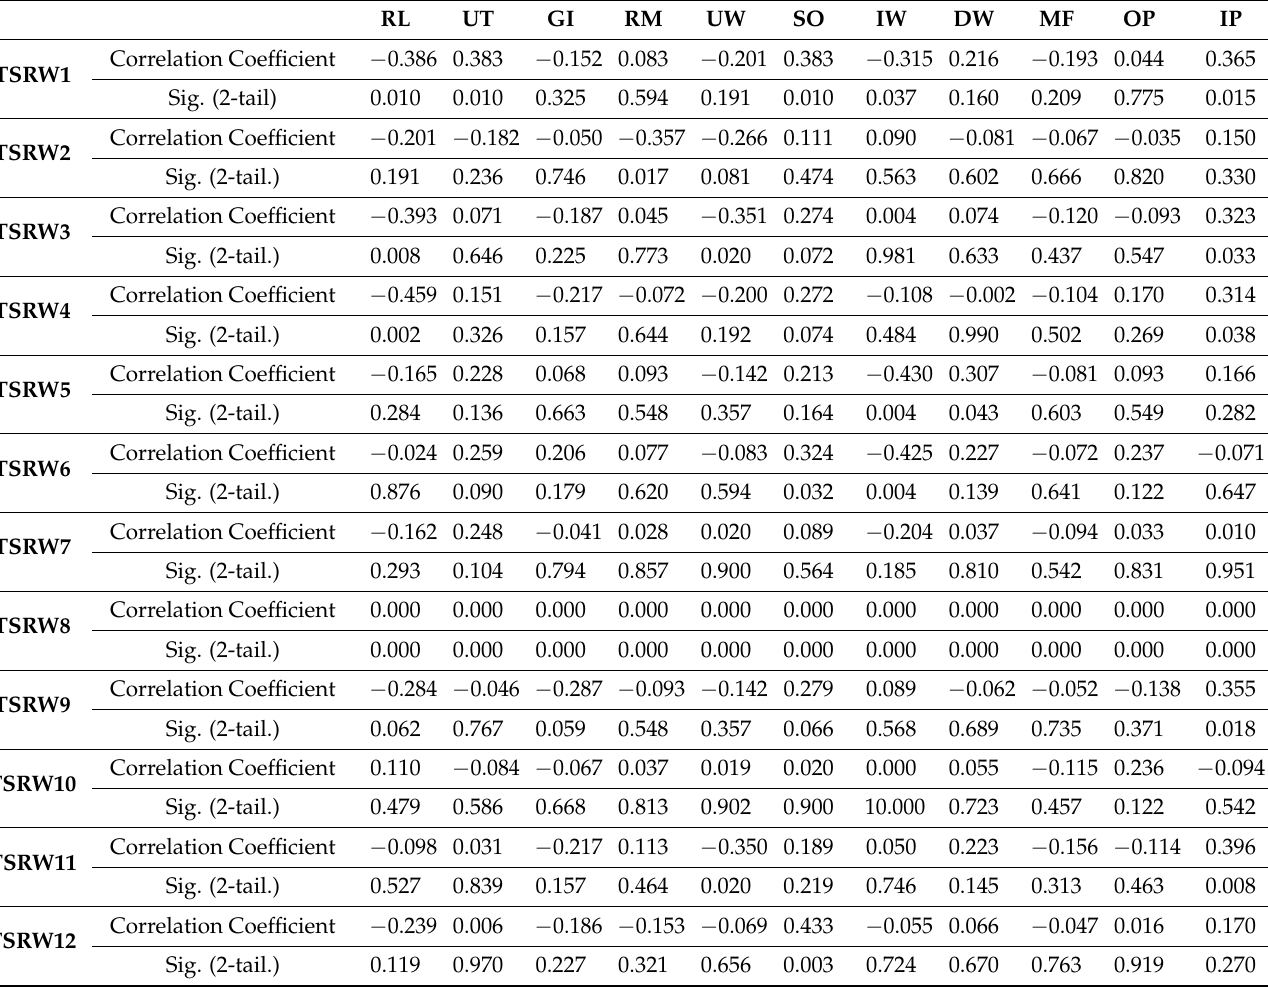
Table A2. Spearman’s ranks for correlations between top struggles of remote work (TSRW) and aspects of operational